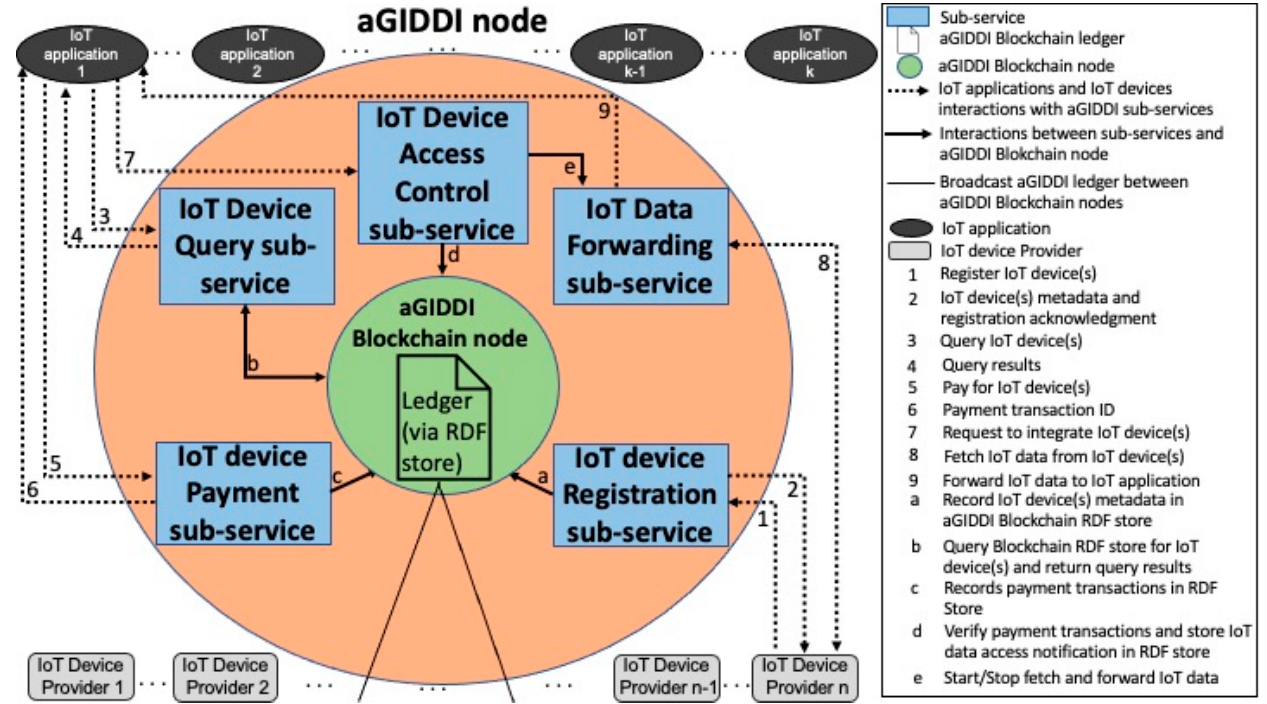
Figure 2. aGIDDI node architecture.